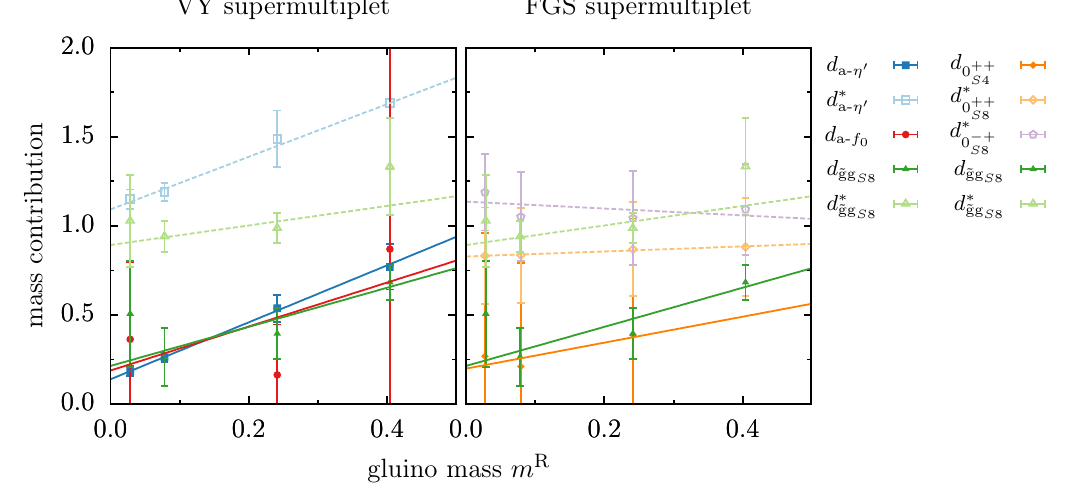
Figure 14 . Left/Right: chiral extrapolation of the VY/FGS-supermultiplet. Each particle is depicted with a different color. Solid/Dashed lines are linear fits to the lowest/next higher mass contribution. The amount of smearing steps is indicated in the indices, e.g. ˜gg stands for 8 S 8 levels of stout smearing. For the gluino-glue the symmetric operator is considered as discussed in section 4.5. Two resp. four time slices are ignored in all correlator fits at the lattice boundary resp. in the center. All fits are 2-cosh except 0 ++ and 0 − + , which are fitted to a single cosh. S 8 S 8 previous sections this extrapolation has been discussed for the individual states